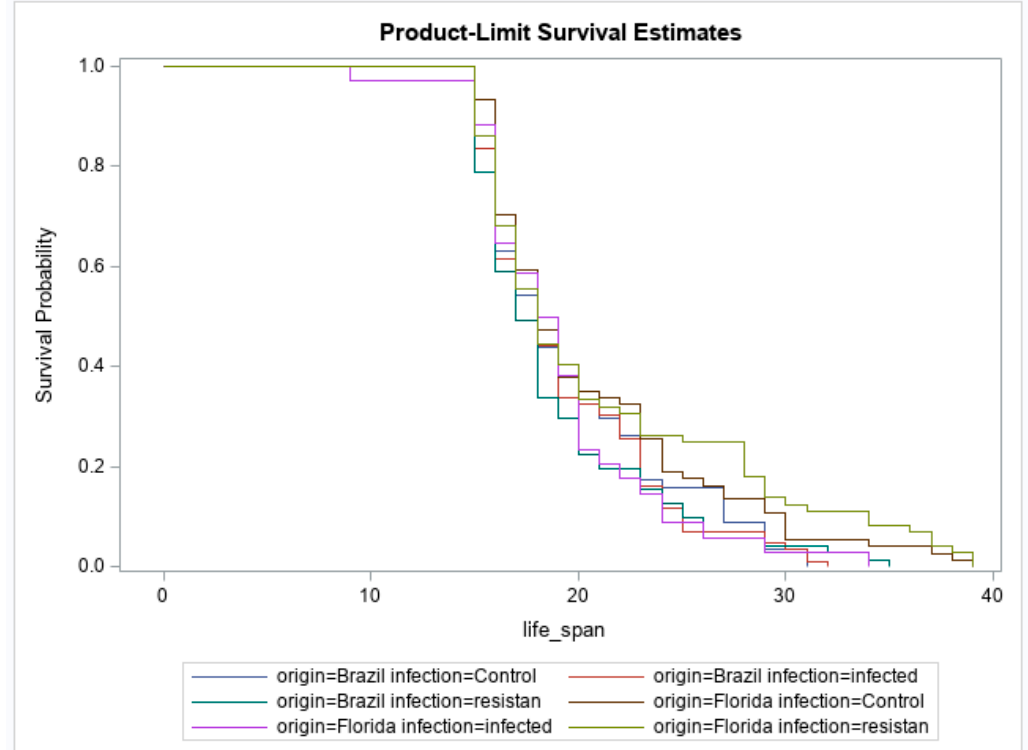
Figure 2. Effects of Mayaro virus (MAYV) infection on adult female survival in Aedes aegypti . Survival probabilities are illustrated according to geographic origin of Ae. aegypti and infection status (Brazil control, n = 57; Brazil infected, n = 86, Brazil resistant / refractory, n = 71; Florida control, n = 74; Florida infected, n = 34, Florida resistant / refractory, n = 74).